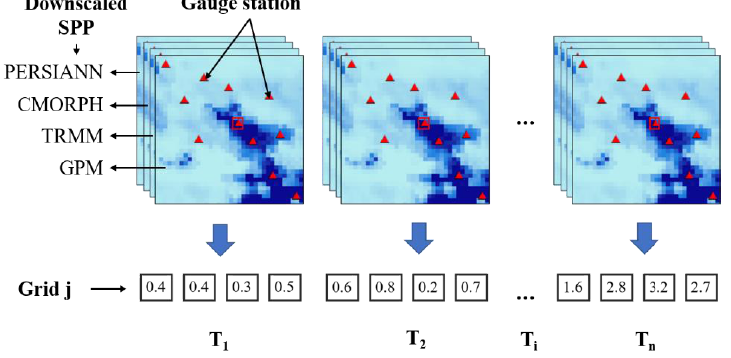
Figure 3. Diagram of 1 × 4 matrix data extraction from multisatellite precipitation datasets.